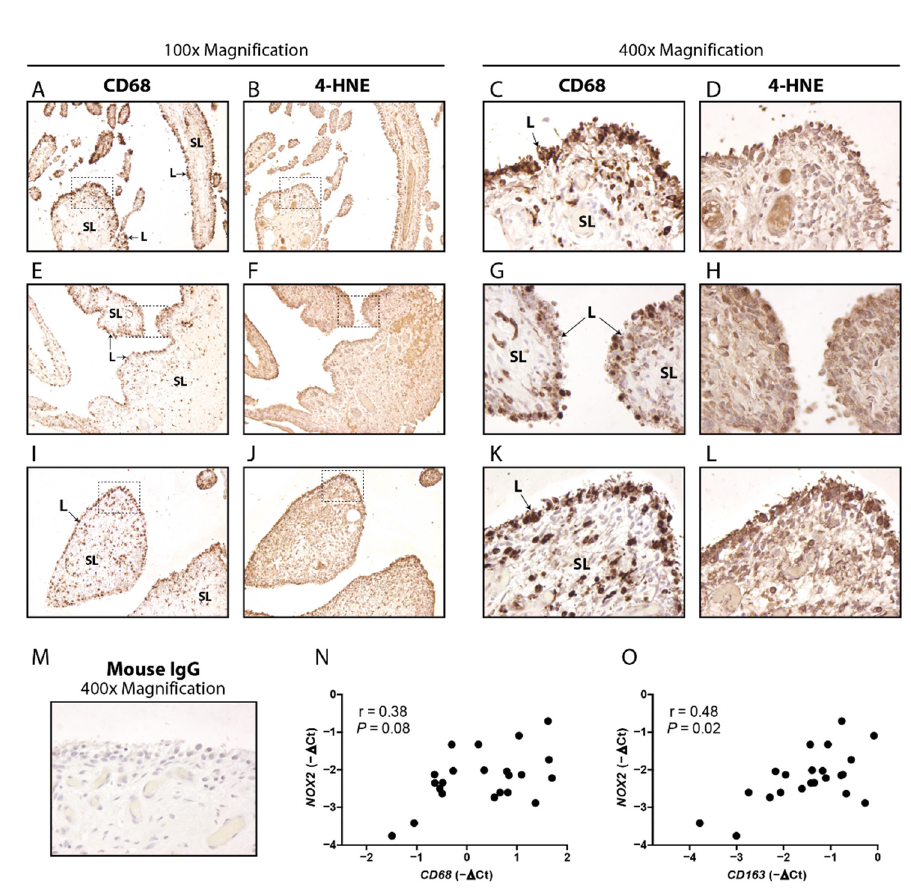
Figure 1. Macrophage marker CD68 and oxidation marker 4HNE are particularly present in the lining of human OA synovium, and CD163 positively correlates with NOX2 . Immunohistochemical staining of CD68 ( A , C , E , G , I , K ) and 4HNE ( B , D , F , H , J , L ) was performed on sections of human OA synovium (100 × and 400 × magnification). Adjacent sections from synovium of three different patients are shown ( A – L ). Dashed square shows area of 400 × magnification. L = lining, SL = sub-lining. Mouse IgG was used as isotype control ( M ). mRNA expression of NOX2 did not correlate with CD68 ( N ), but did positively correlate with CD163 ( O ) in human OA